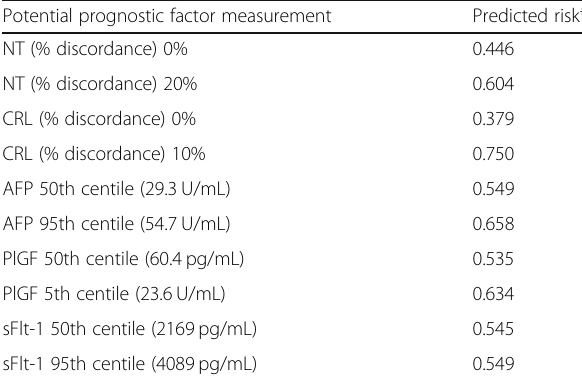
Table 4 Predicted risk of developing a fetal adverse outcome according to potential prognostic factor measurements determined a priori Potential prognostic factor